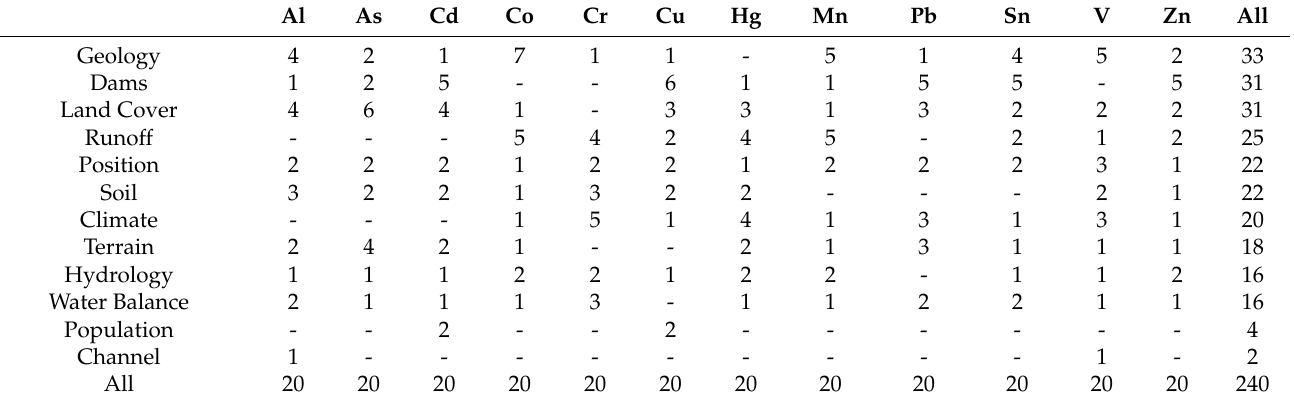
Table 3. The distribution of the 20 MIV of all 12 models into the 12